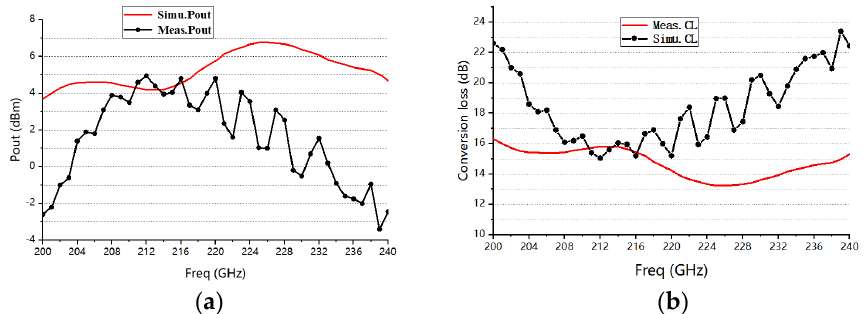
Figure 17. ( a ) Output power at fixed 100 mW power rate. ( b ) Conversion loss at fixed 100 mW power.